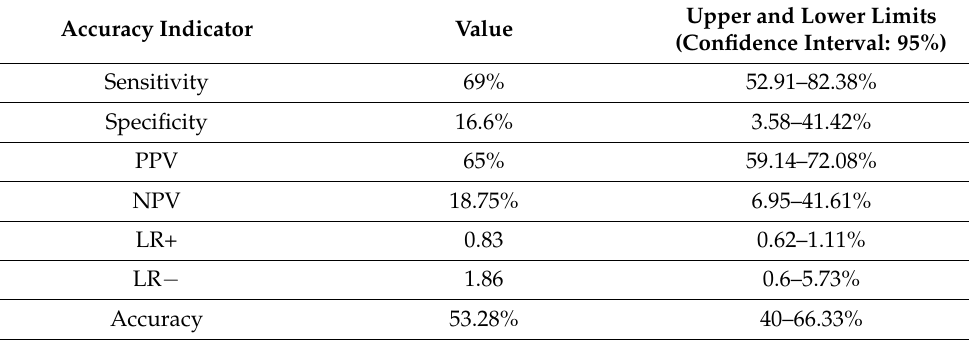
Table 3. Summary of the accuracy indicators of Pont’s analysis based on the contingency table (Table 2).